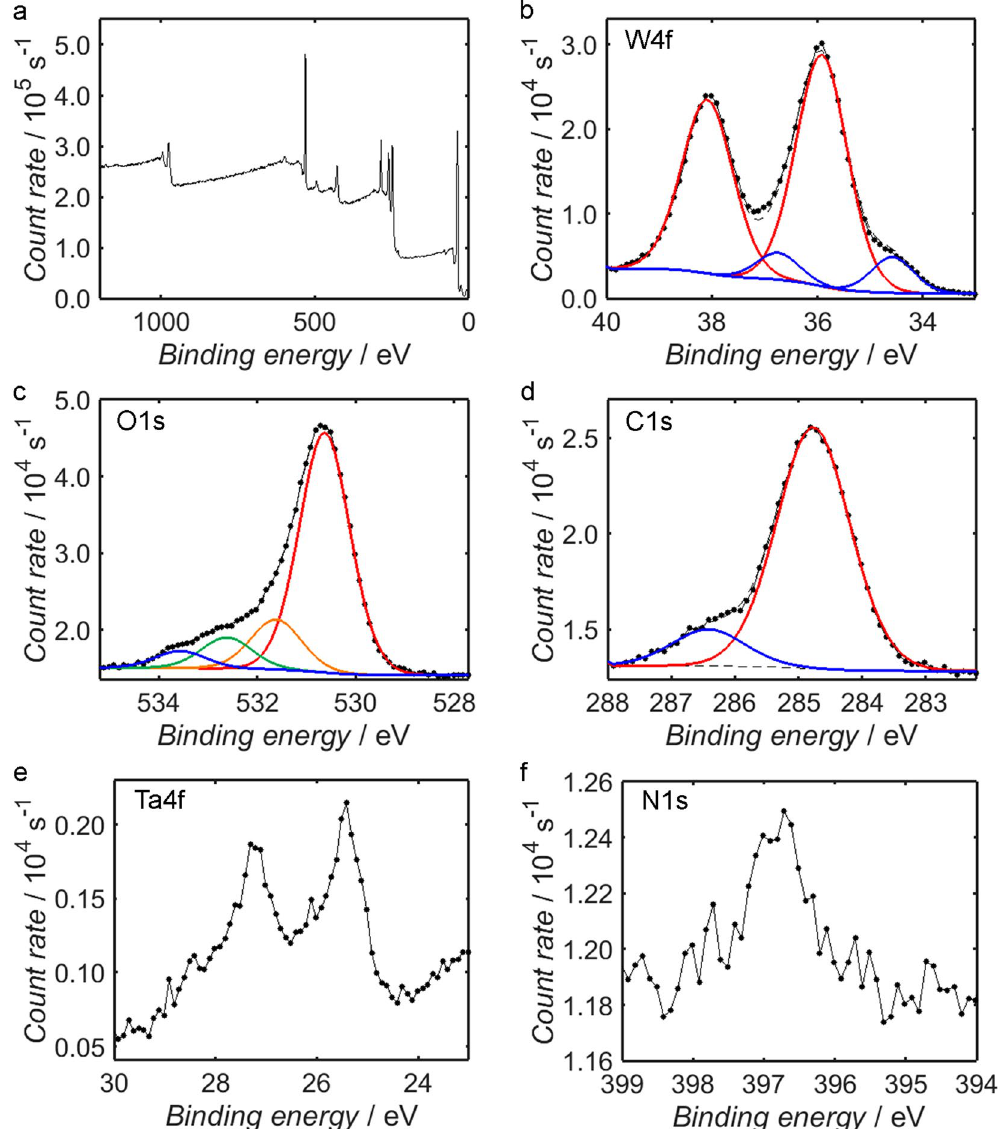
Figure 4. XPS measurements of the Ta 3 N 5 /W 18 O 49 binding energy spectrum over the range 0–1200 eV ( a ), in addition to higher resolution measurements of the W4f ( b ), O1s ( c ), C1s ( d ), Ta4f ( e ) and N1s ( f ) peaks. Shirley fits to secondary electron backgrounds are shown as black dashed lines, while fitted peak components are plotted as solid, coloured lines; fitted peaks contained within the same doublet have been assigned the same